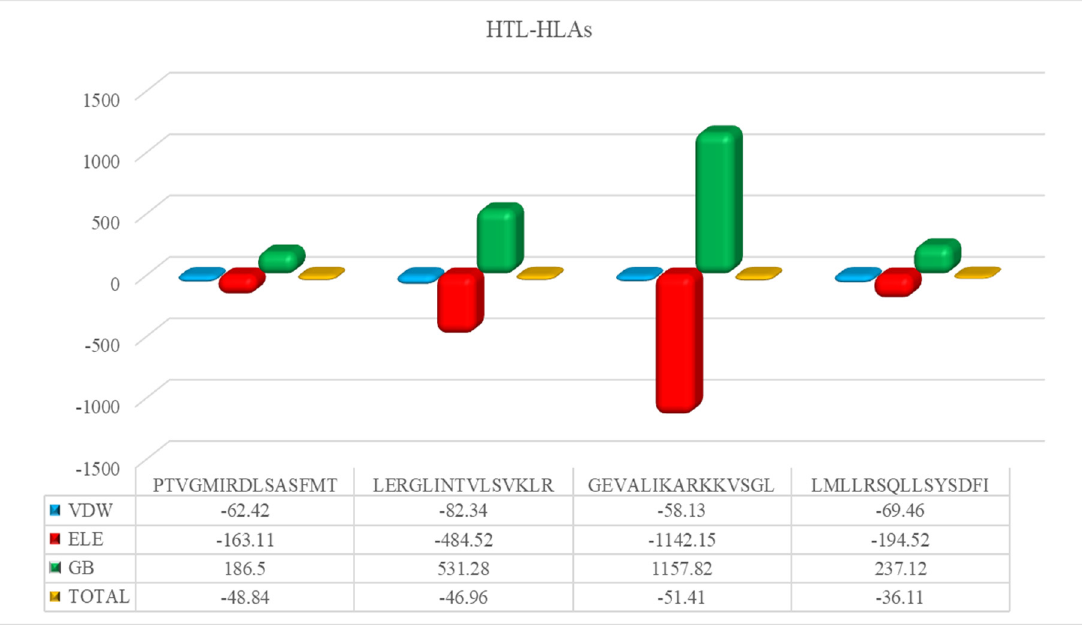
Figure 6. The vDW energy, Electrostatic, and Binding free energy for selected HTL epitopes in com- plex with respective HLA molecules.